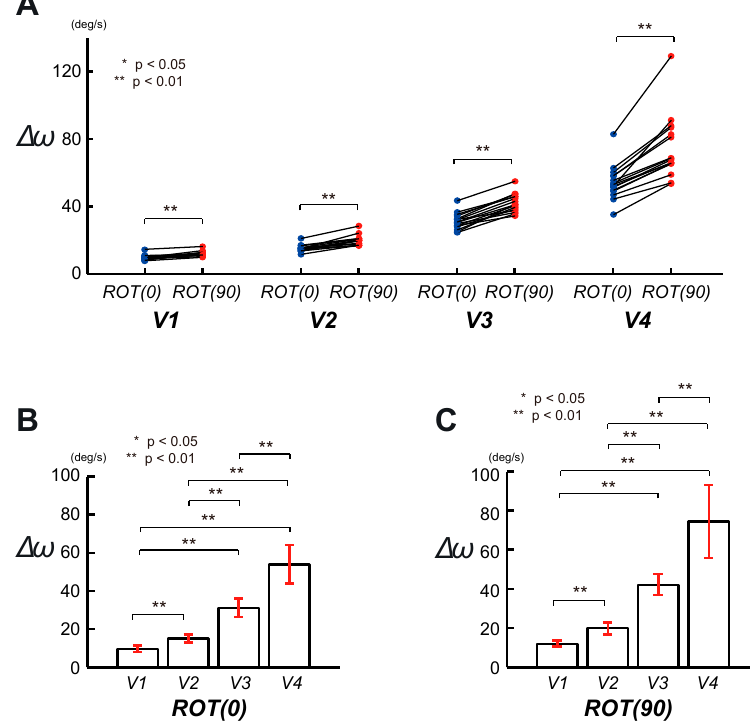
Figure 5. Evaluation of the circular tracking movement based on Δ ω in 3D VR space. ( A ) The graphs indicate the pairwise comparison of Δ ω analyzing the speed factor between ROT (0) and ROT (90). ( B ) The pairwise comparison was performed for Δ ω , on the frontal plane ( ROT (0)), at four target speeds. ( C ) The pairwise comparison was performed for Δ ω , on the sagittal plane ( ROT (90)) at four target speeds.